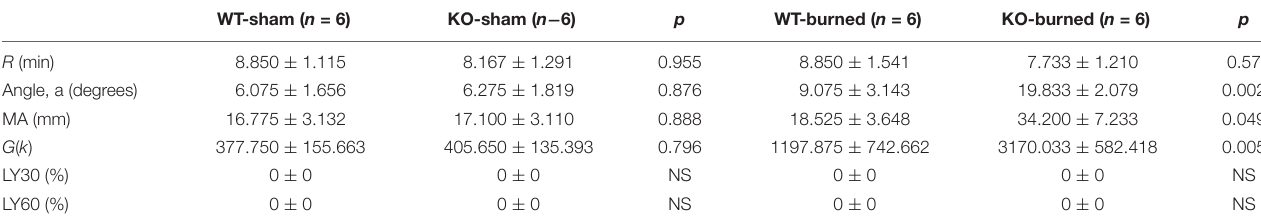
TABLE 3 | Comparison of P311 WT and P311-KO mice after burned and sham